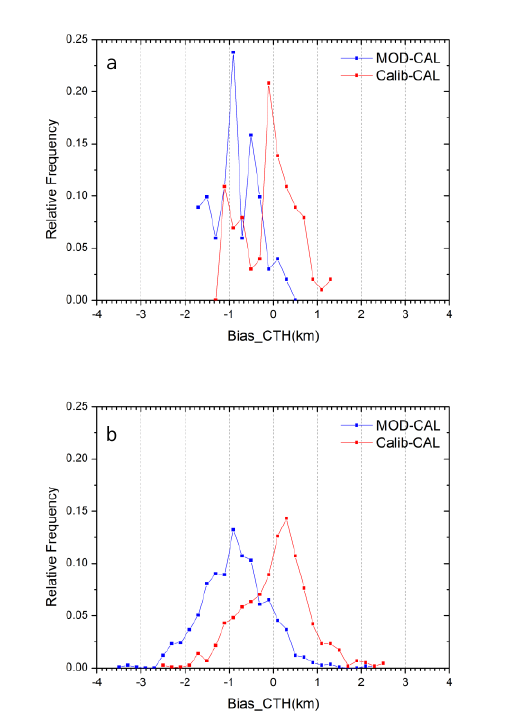
Figure 4. Comparison of correction for cloud top height of Figure 5. Comparison of correction for cloud top height of cirrus at different altitudes in 2017 cirrus at different cloud optical depth in 2017 (a, b, c, d, e and f represent the comparison at raw MODIS < 8, (a, b, c and d represent the comparison of the raw cloud optical 8-9, 9-10, 10-11, 11-12 and > 12 km, respectively; blue and red depth at 0~1.0 、 1.0~2.0 、 2.0~3.0 、 3.0~3.6, respectively; blue line represent probability distribution for the difference between and red line represent probability distribution for the difference height of raw MODIS and CALIPSO, corrected MODIS and between height of raw MODIS and CALIPSO, corrected CALIPSO) MODIS and CALIPSO)